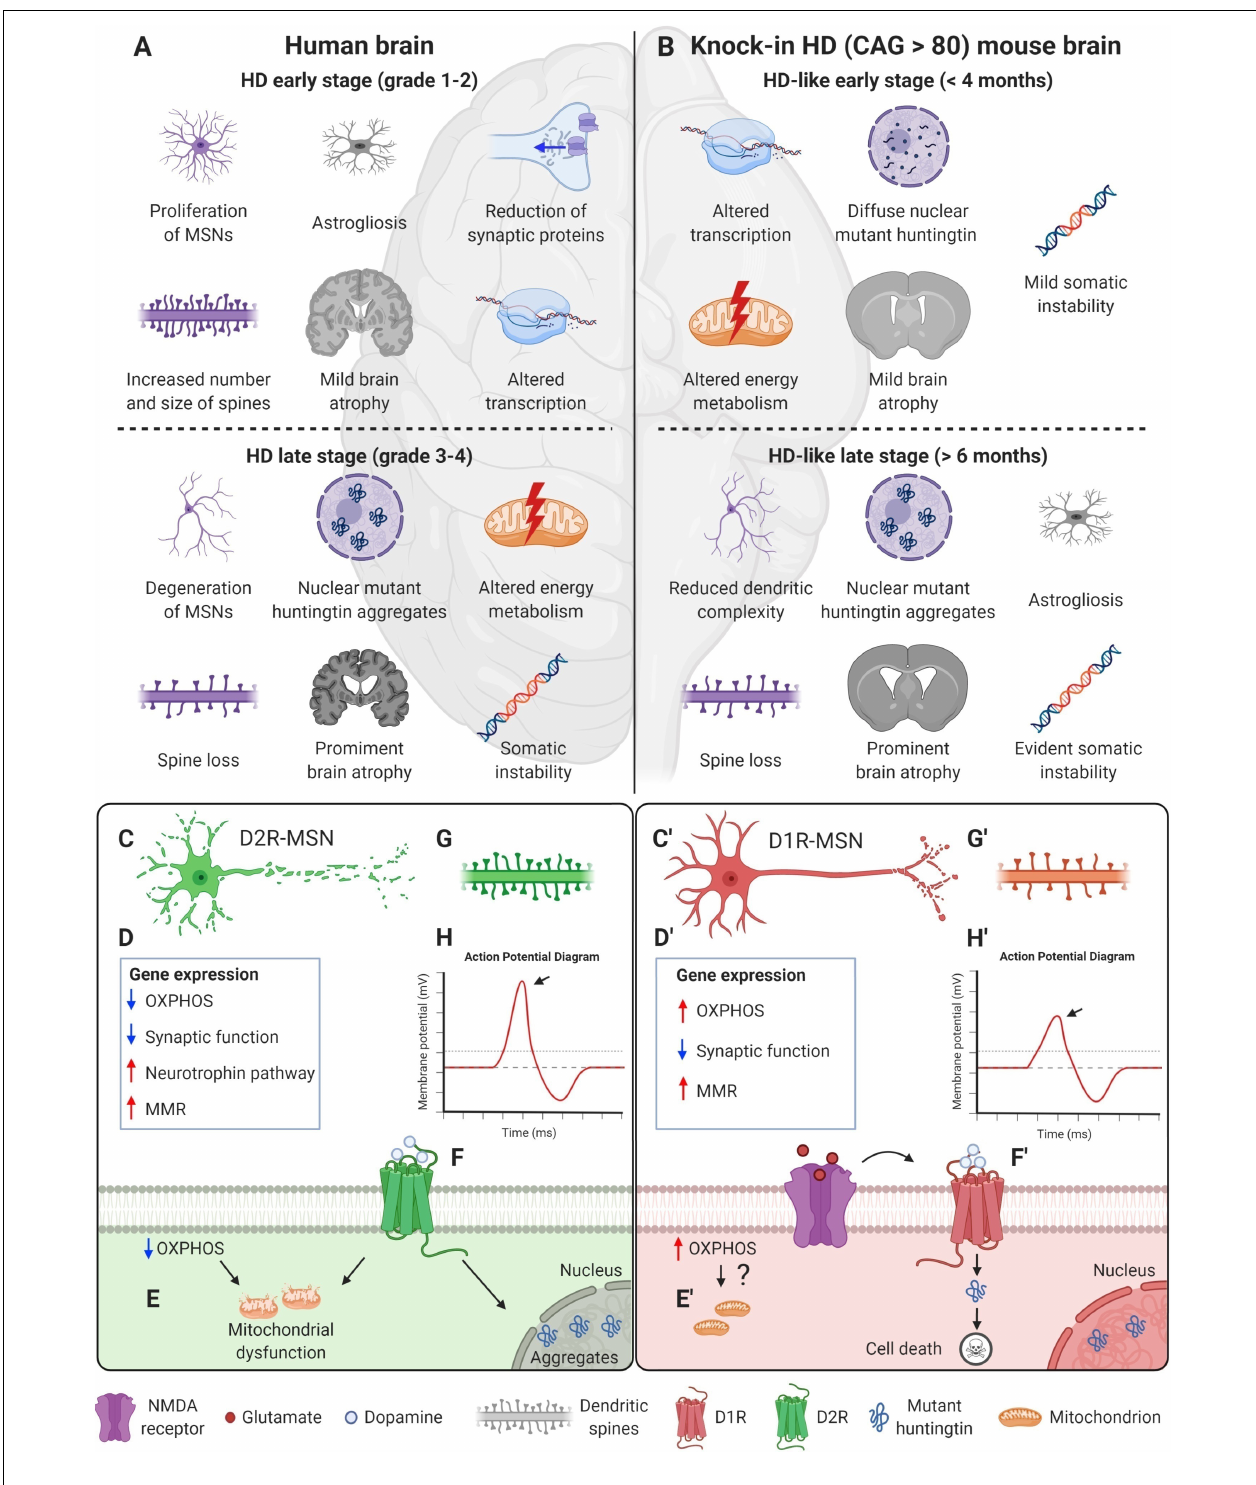
FIGURE 1 | HD profoundly alters the striatum and MSNs in both patients and mouse models, upper panel. (A) Schematic representation of HD patient brain. At the early stage of the disease (grade 1–2), patients already manifest mild brain atrophy and astrogliosis (Ross and Tabrizi, 2011; Rüb et al., 2016). MSNs undergo proliferative expansion and show increased number and size of spines (Ferrante et al., 1991). At the molecular level, a reduction of synaptic proteins and alterations in gene transcription are detected (DiProspero et al., 2004; Hodges et al., 2006). These changes continue during advanced stages (grade 3–4), when brain atrophy becomes prominent (Rüb et al., 2016). MSNs undergo degenerative changes and spine loss, and mutant huntingtin aggregates can be detected within nuclei